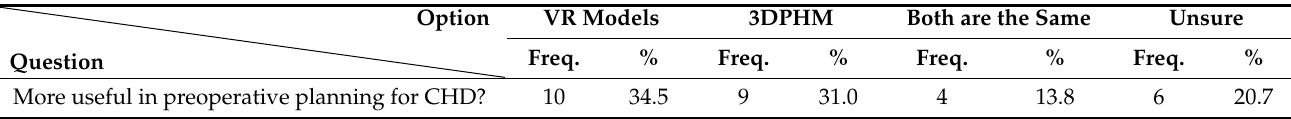
Table 4. Participants’ responses on the usefulness of VR and 3DPHM in preoperative planning for CHD.